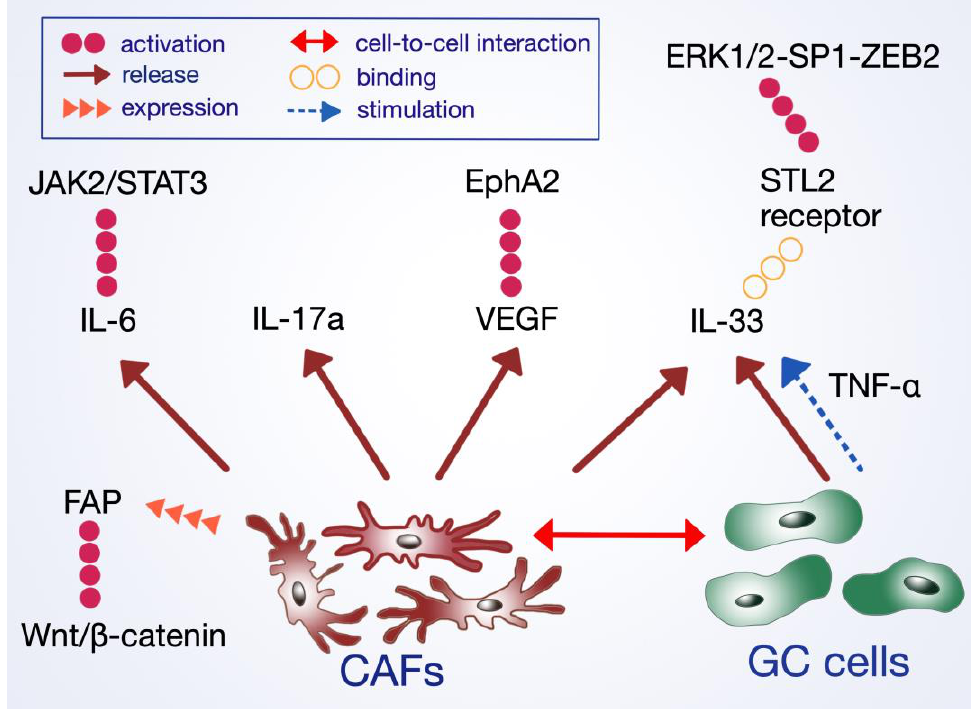
Figure 2. Mechanisms of cancer-associated fibroblasts action in EMT and gastric cancer progression.